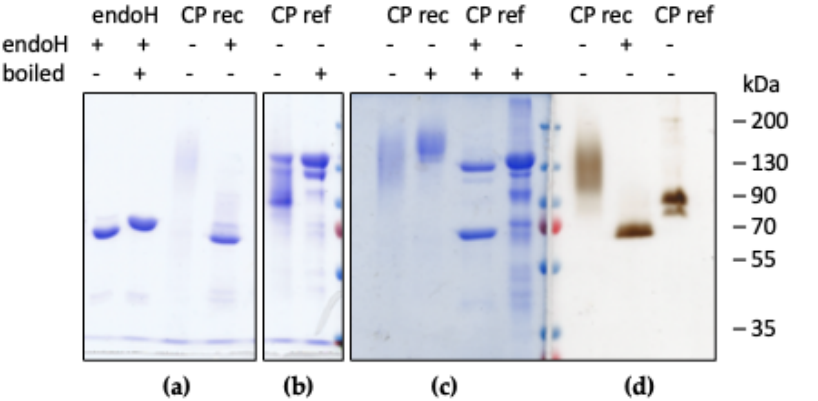
Figure 3. SDS-PAGE analysis of purified recombinant CP before and after treatment with endoH. Recombinant CP was incubated with EndoH in non-denaturing conditions. Samples of recombinant CP (CP rec, 1 μ g in panel ( a ), 3 μ g in panels ( b – d )) and of plasma-derived CP (CP ref, 5 μ g) were loaded with or without heat treatment as indicated. EndoH is shown in the first two lanes. Panels